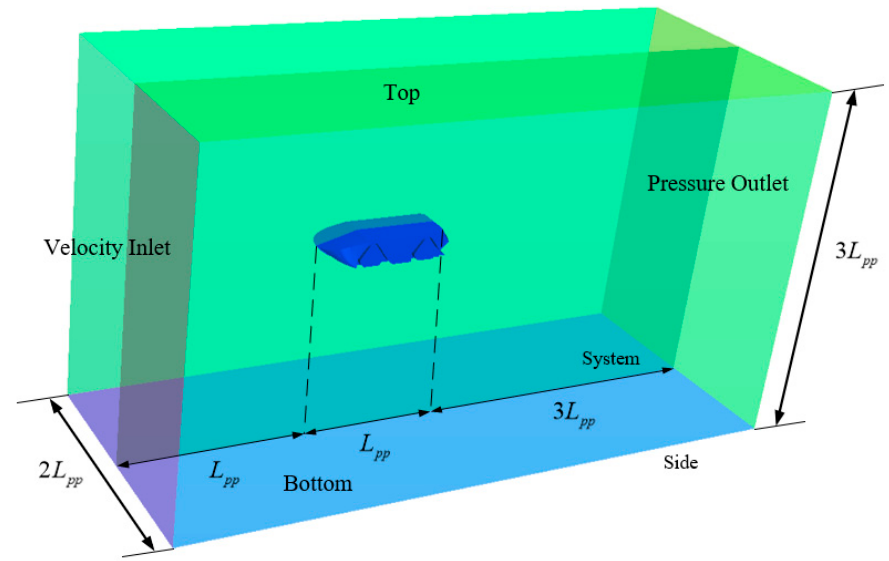
Figure 6. Computational domain.